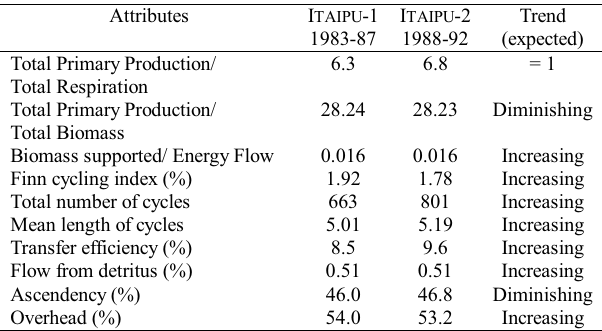
Table 3. Attributes of ecosystem maturity for the Itaipu reser- voir models. Trend indicates the expected behavior by Odum